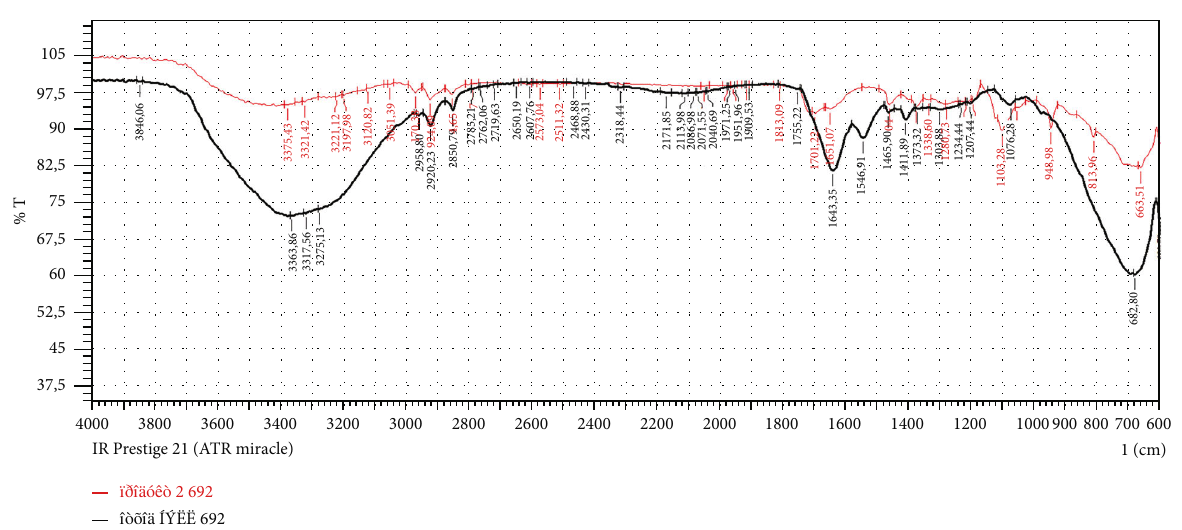
Figure 1: IR spectra of soap stock re fi ning sun fl ower oil and a mixture composition of unsaturated and saturated fatty